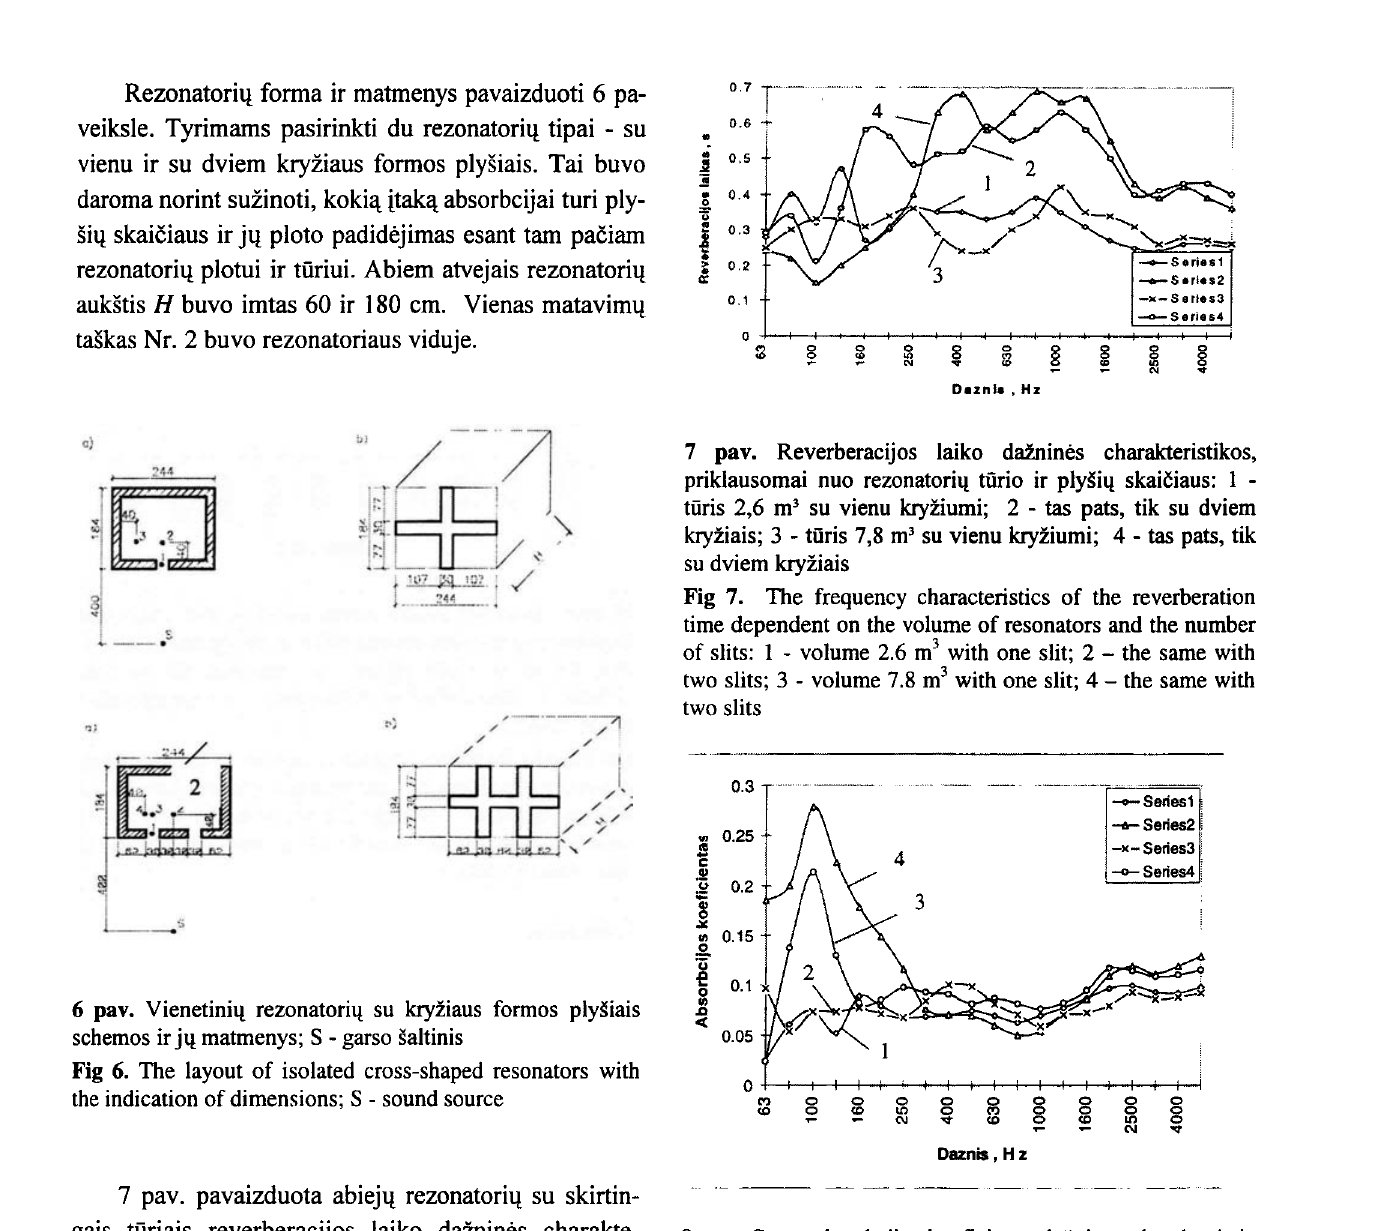
7 pav. pavaizduota abiejq rezonatoriq su skirtin gais turiais reverberacijos laiko dafuines charakte ristikos, kurios gautos aproksimuojant garso lauko slo pimllnuo 0 iki -30 dB.